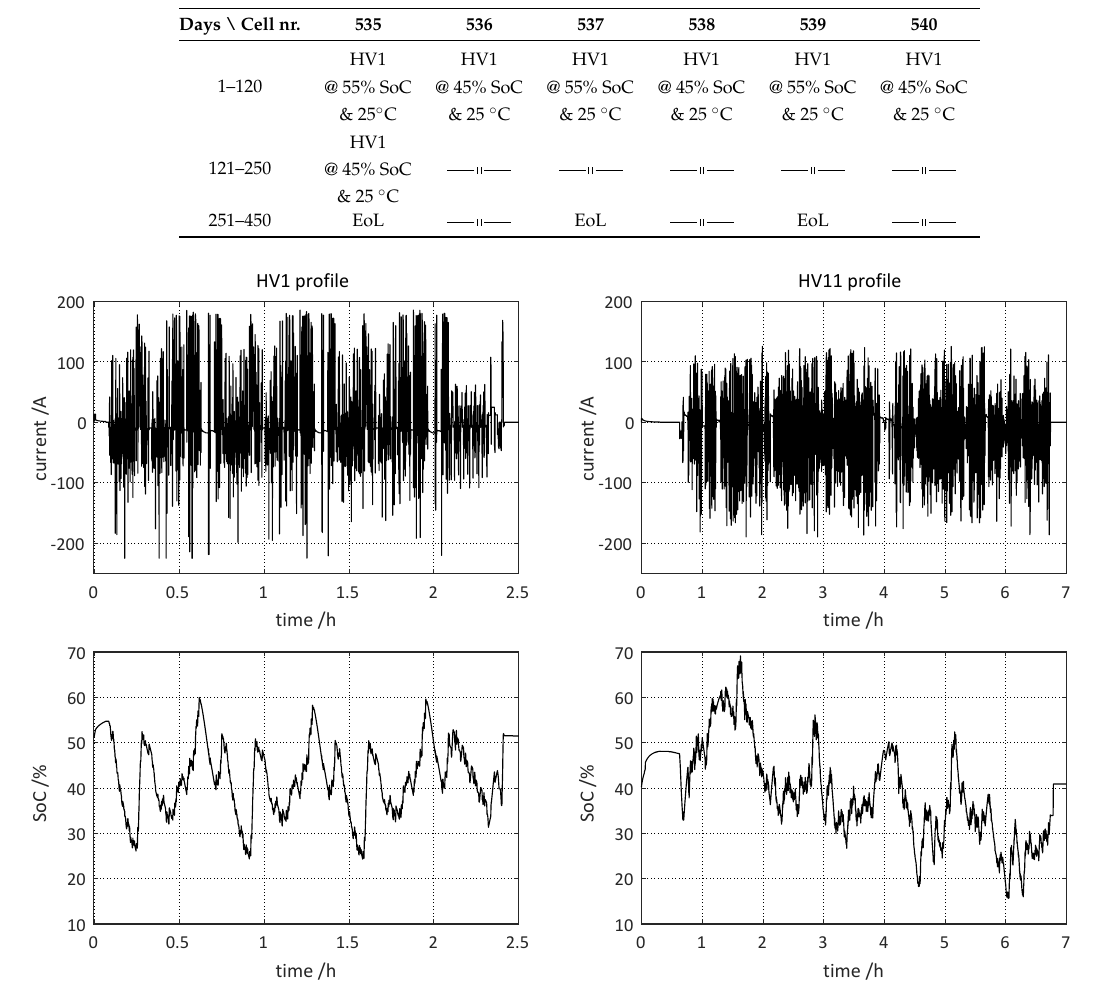
Figure 3. Some of the deployed load profiles with their corresponding SoC-trends below.